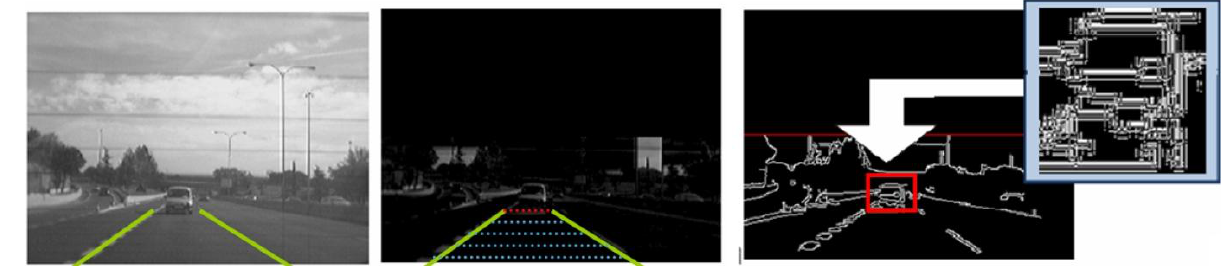
Figure 4. From left to right: original image; contact point detection on white top-hat image; candidate pre-selected with high entropy of Canny